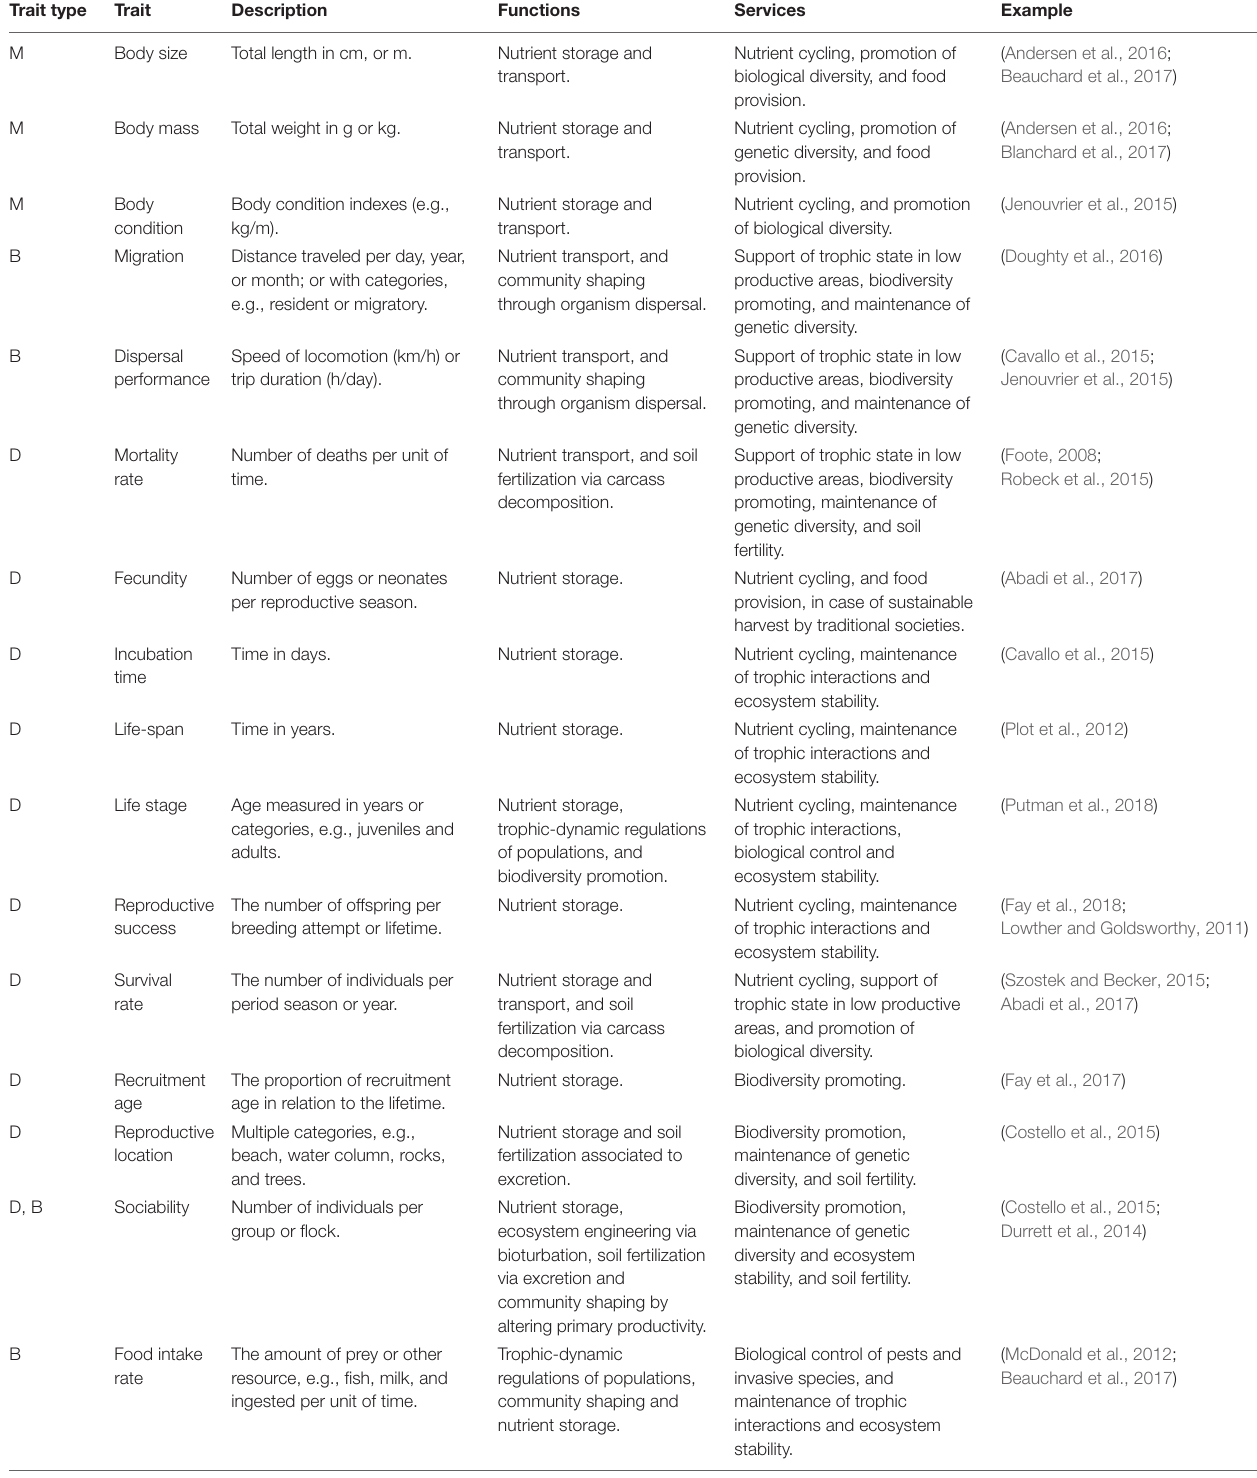
TABLE 1 | Summary of traits of marine megafauna and the related ecosystem functions and services. Trait